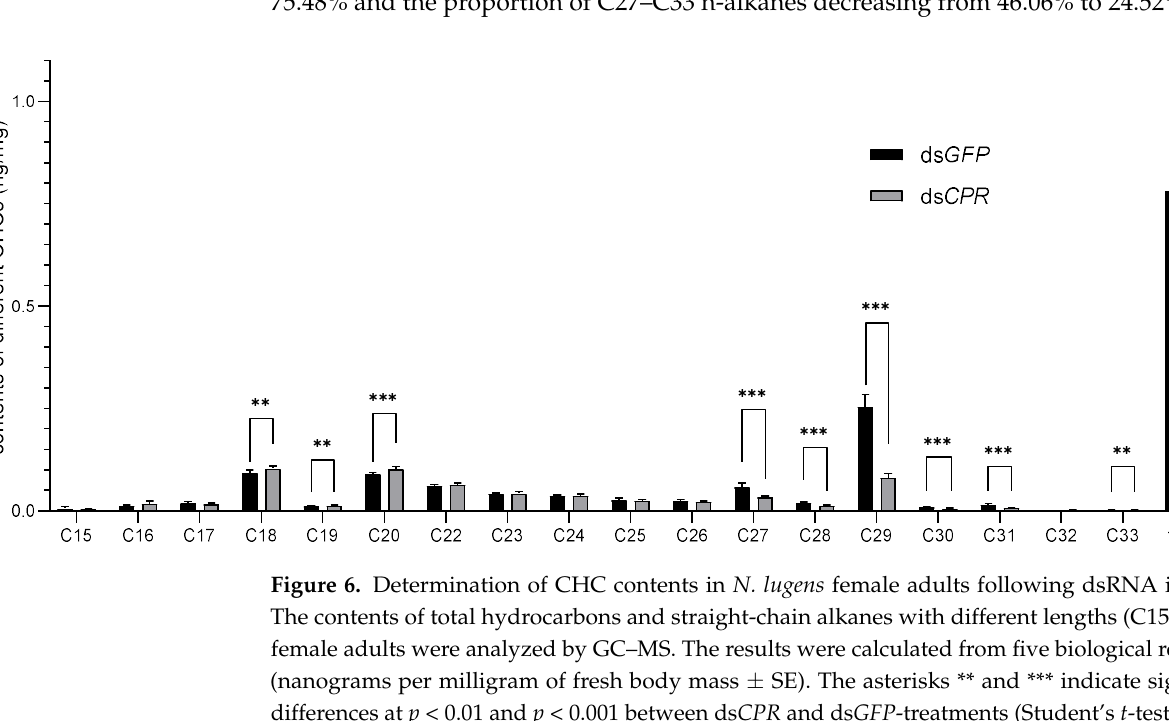
Figure 5. Scanning electron microscope analysis of the outermost layer in the abdominal surface. The 4th-instar nymphs at 48 h after molting were injected with dsRNAs and the 5th-instar nymphs at 48 h after emergence were collected for SEM. ( A ) ds GFP -injected insects were washed with water; ( B ) ds CPR -injected insects were washed with water; ( C ) ds GFP -injected insects were washed with hexane; ( D ) ds CPR -injected insects were washed with hexane. The 4th abdominal segment of the nymphs are shown.